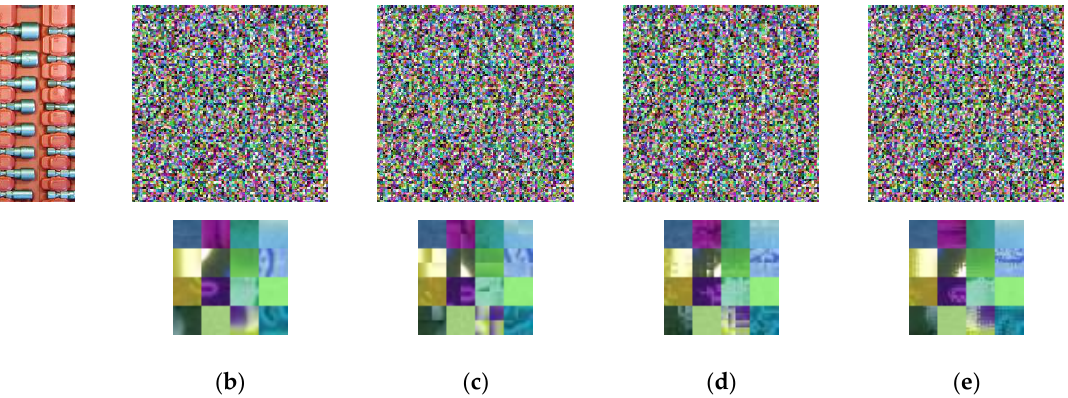
Figure 3. Visual analysis of inter and intra block processing on example image from Tecnick dataset. ( a ) Plain image. ( b ) Conventional EtC method (16 × 16). ( c – e ) Encrypted image of the proposed method with sub – block size (8 × 8), (4 × 4), and (2 × 2), respectively. The last row shows enlarged image of the bottom left corner in each encrypted image. Compared to conventional methods, the proposed method achieves visual encryption of local details.